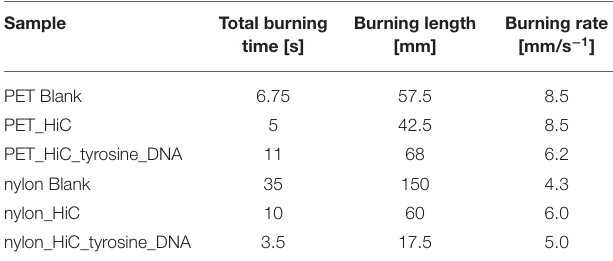
TABLE 2 | Flammability of PET and nylon fabrics after enzymatic surface activation and coupling of DNA. Sample